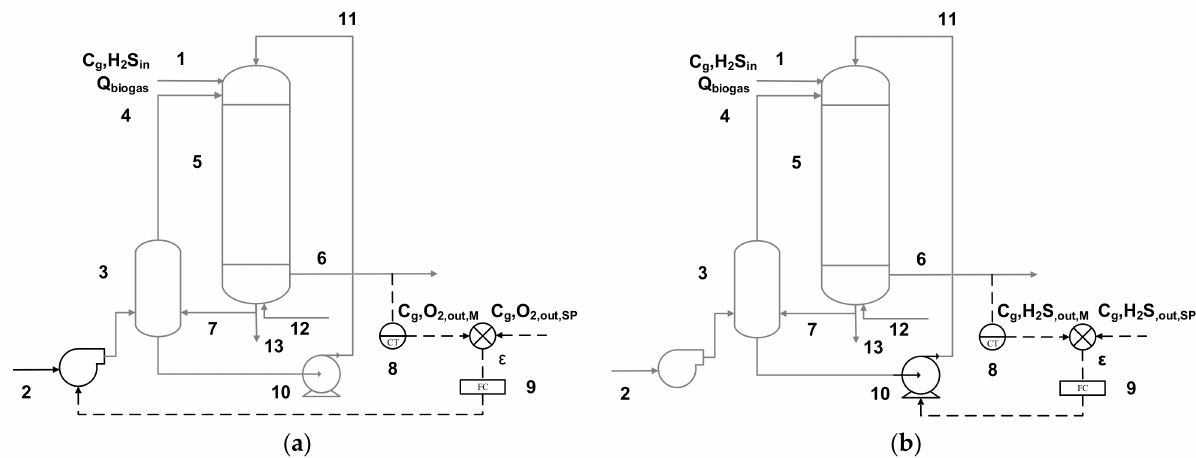
Figure 1. Schematic of control strategy ( a ) for controlling C g,O through gas flowrate regulation ( b ) for controlling 2 ,out C g,H through liquid recirculation flowrate in a co-current BTF set up: (1) biogas inlet, (2) Air flow inlet to the aeration 2 S,out column, (3) aeration column, (4) Air flow inlet to the BTF, (5) main reactor, (6) biogas outlet, (7) liquid recycled, (8) H 2 S and O 2 transmitters, (9) feedback controller, (10) recycling pump, (11) recycling liquid line to the BTF (12) mineral medium and bicarbonate supply, (13) liquid